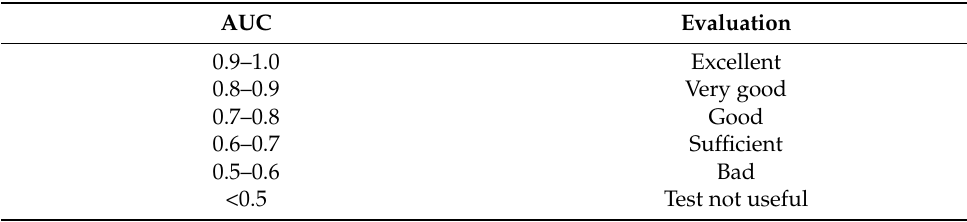
Table 4. Evaluation of vulnerability according to area under the curve